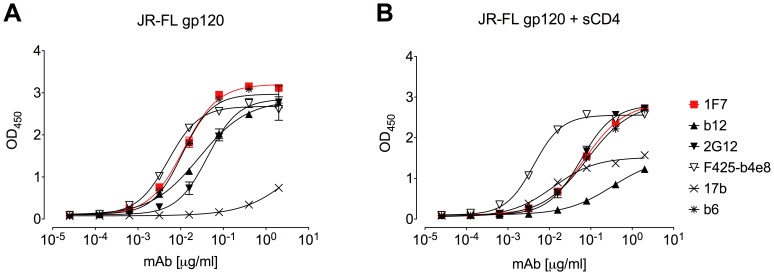
Soluble CD4 competes with mAb 1F7 for binding to gp120.MAb binding to gp120JR-FL was measured using ELISA in the absence (A) or in the presence of sCD4 (B). MAb b12 was significantly inhibited by sCD4 (∼13-fold shift at half-maximum binding) whereas 1F7 exhibited a 6-fold shift and mAb b6 a 4-fold shift. The binding of control mAbs F425-B4e8 (V3) and 2G12 (binds to silent face of gp120) was not inhibited by sCD4, as expected. Each assay was performed in duplicate. Data are representative of at least 3 repeats.